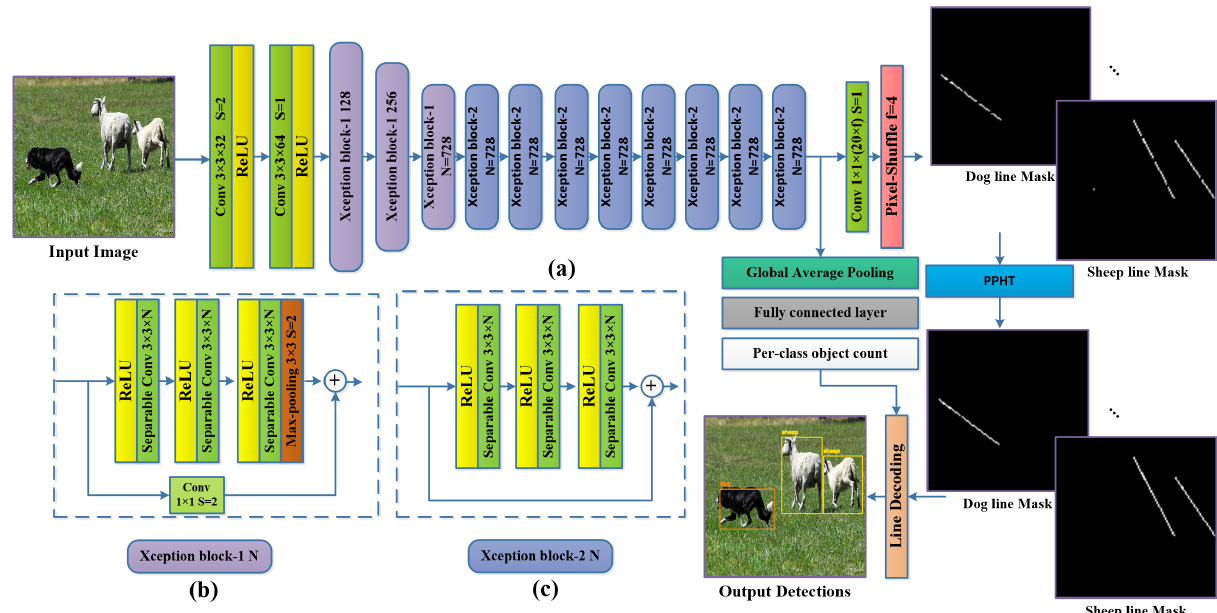
Figure 2. The proposed method. ( a ) The Xception-16 architecture with two branches: one for predicting the line mask for each object and the other branch for per-class object count by regression, which is employed in the post-processing stage of the line decoding. ( b ) Xception block-1 is the Xception block that consists of three sequential RELU+ 3 × 3 × N separable convolution2D and a 3 × 3 max-pooling with stride (s) of 2, a skip connection with 1 × 1 convolution2D and stride of 2. ( c ) Xception block-2 is the Xception block that consists of three sequential RELU+ 3 × 3 × N separable convolution2D.